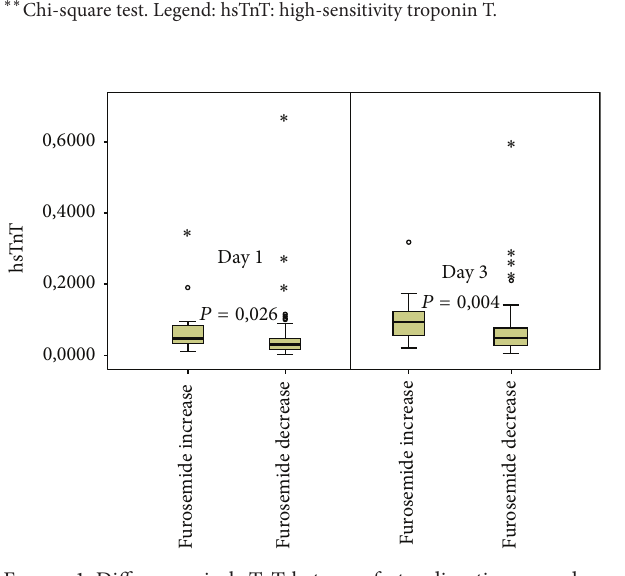
Figure 1: Differences in hsTnT between faster diuretic responders and slower diuretic responders at day 1 and day 3. hsTnT: high- sensitivity troponin T (ng/mL).